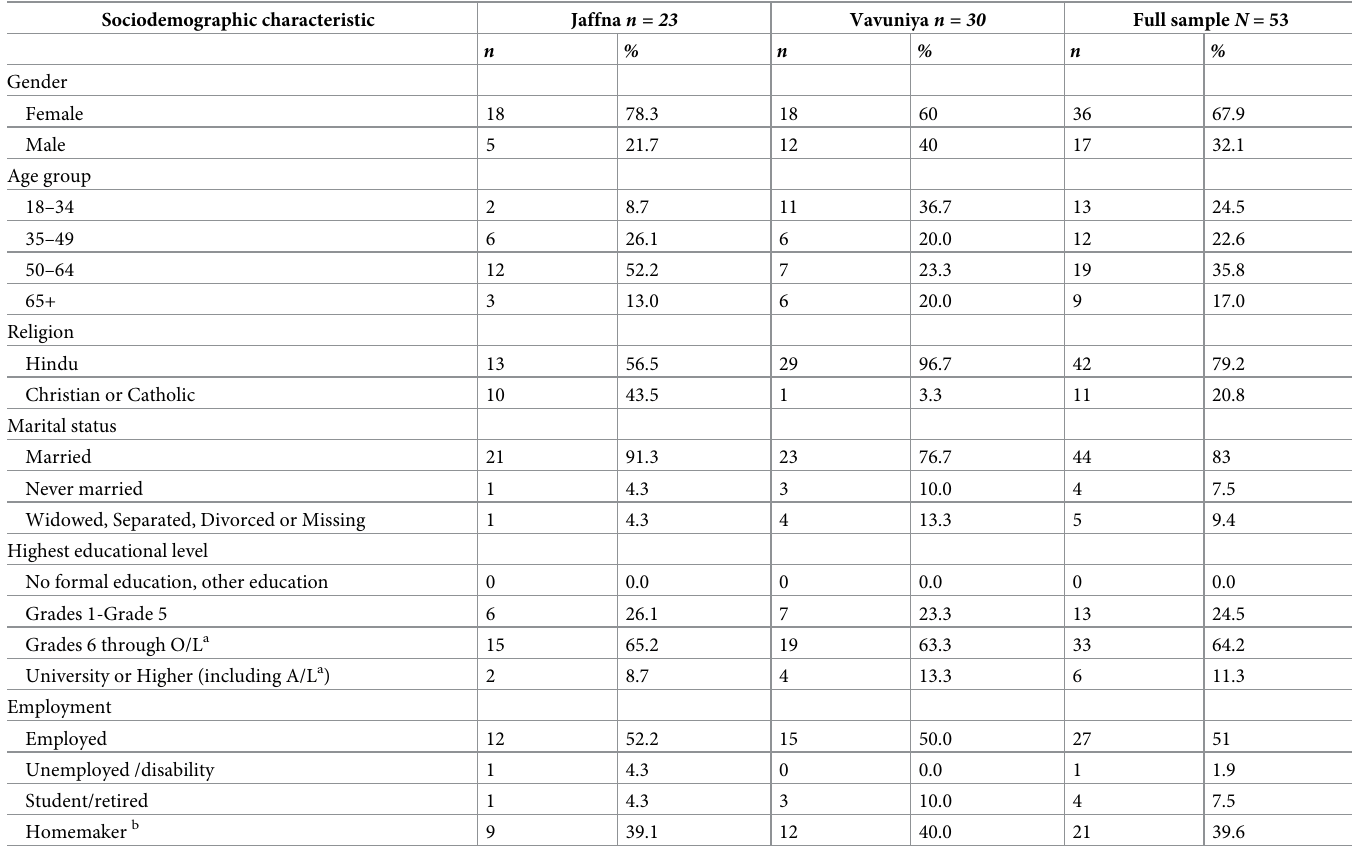
Table 1. Sociodemographic characteristics of